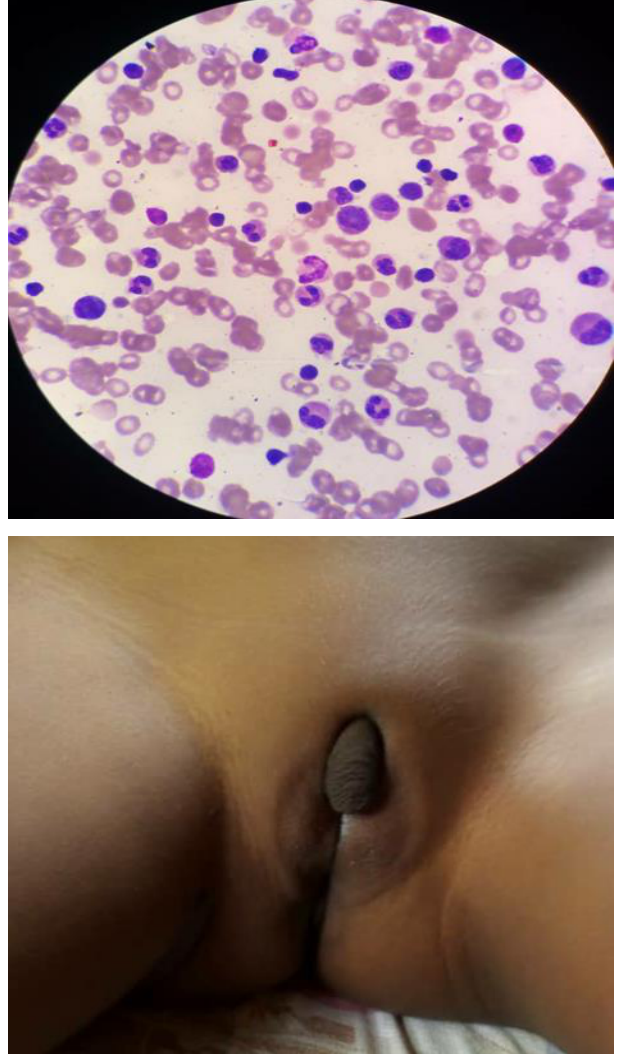
Figs. 1. Photomicrograph of bone marrow in case report two showing markedly reduced red cell precursors with normal granulocyte and megakaryocytic cell counts. The second image demonstrates an abnormal female external genitalia in case report